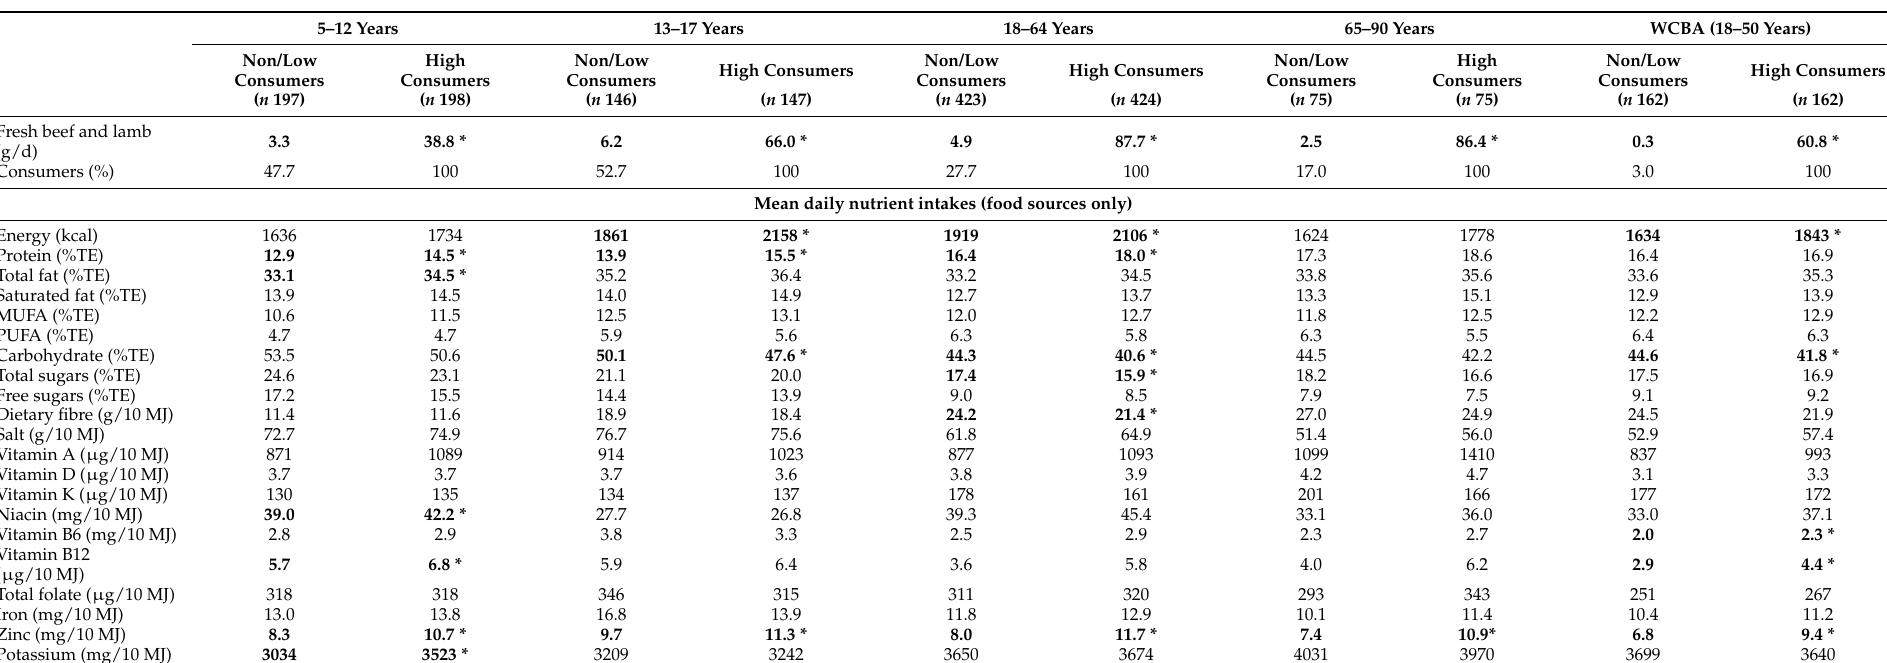
Table 3. Mean daily intakes of energy and selected nutrients (energy adjusted) from food sources only (excluding nutritional supplements) in non/low and high consumers of ‘fresh beef and lamb’ in the total population aged 5–90 years, by age